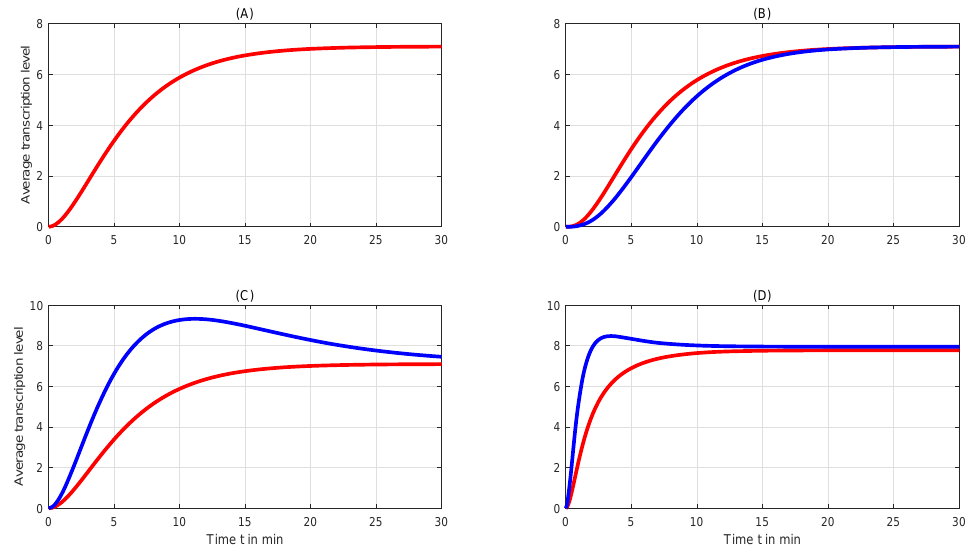
Figure 3. The mean transcription levels produced in different systems. ( A ) two-state transcription system; ( B ) three-state transcription system; ( C ) the cross-talking transcription system; ( D ) two-ON transcription